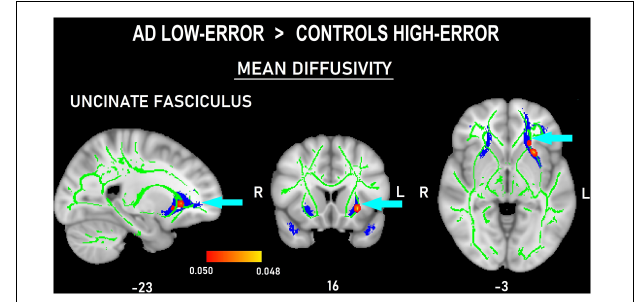
FIGURE 5 | Probability map of tract-based spatial statistics in the uncinate fasciculus showing clusters with increased mean diffusivity in patients with AD committing a low number of errors compared to controls committing a high number of errors. Sagittal (left) , coronal (middle) , and axial (right) radiological views with corresponding MNI coordinates. The red-yellow shade bar indicates the significant p value range. The fractional anisotropy skeleton is shown in green. The area corresponding to the uncinate fasciculus is shown in blue.